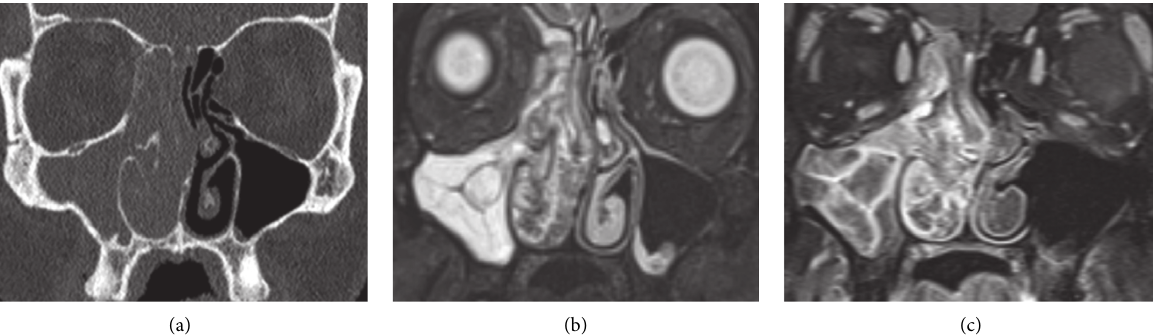
Figure 7: Inverted papilloma (IP) in a 32-year-old male with a 18-month history of rhinorrhoea. (a) Coronal unenhanced CTshows right unilateral maxillary sinus opacification (UMSO) with complete obstruction of the ostiomeatal unit. Bowing of the nasal septum and amorphous faint calcification could be associated with fungal disease; however, (b) coronal STIR and (c) contrast-enhanced T1W demonstrate a right nasal cavity lesion with the typical “cerebriform” appearance of IP and attachment point at the inferior orbit. Hy- perintense right UMSO with mucosal enhancement indicates inspissated secretions rather than lesion extension.